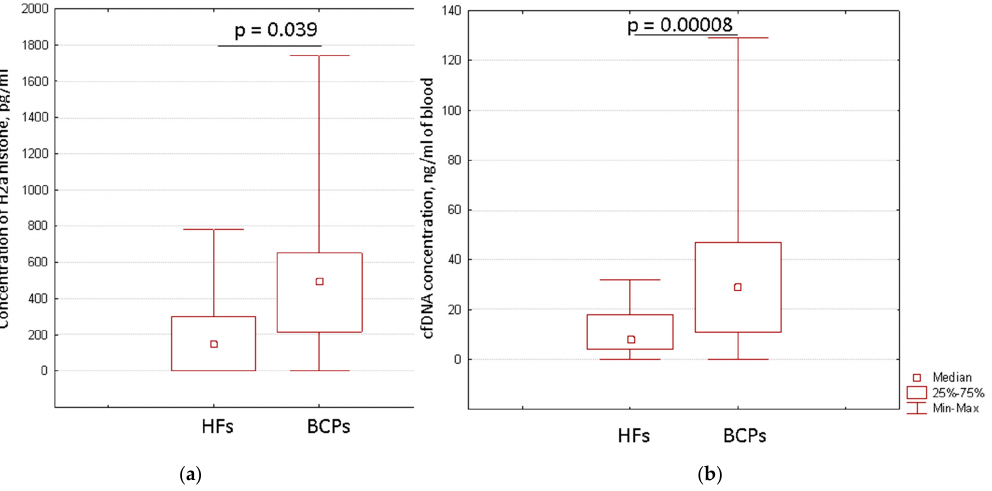
Figure 1. Concentration of histone H2a ( a ) and cfDNA ( b ) from the blood plasma of HFs and BCPs. Tukey box plots, median concentration with 25–75% and non-outlier range bars are indicated.